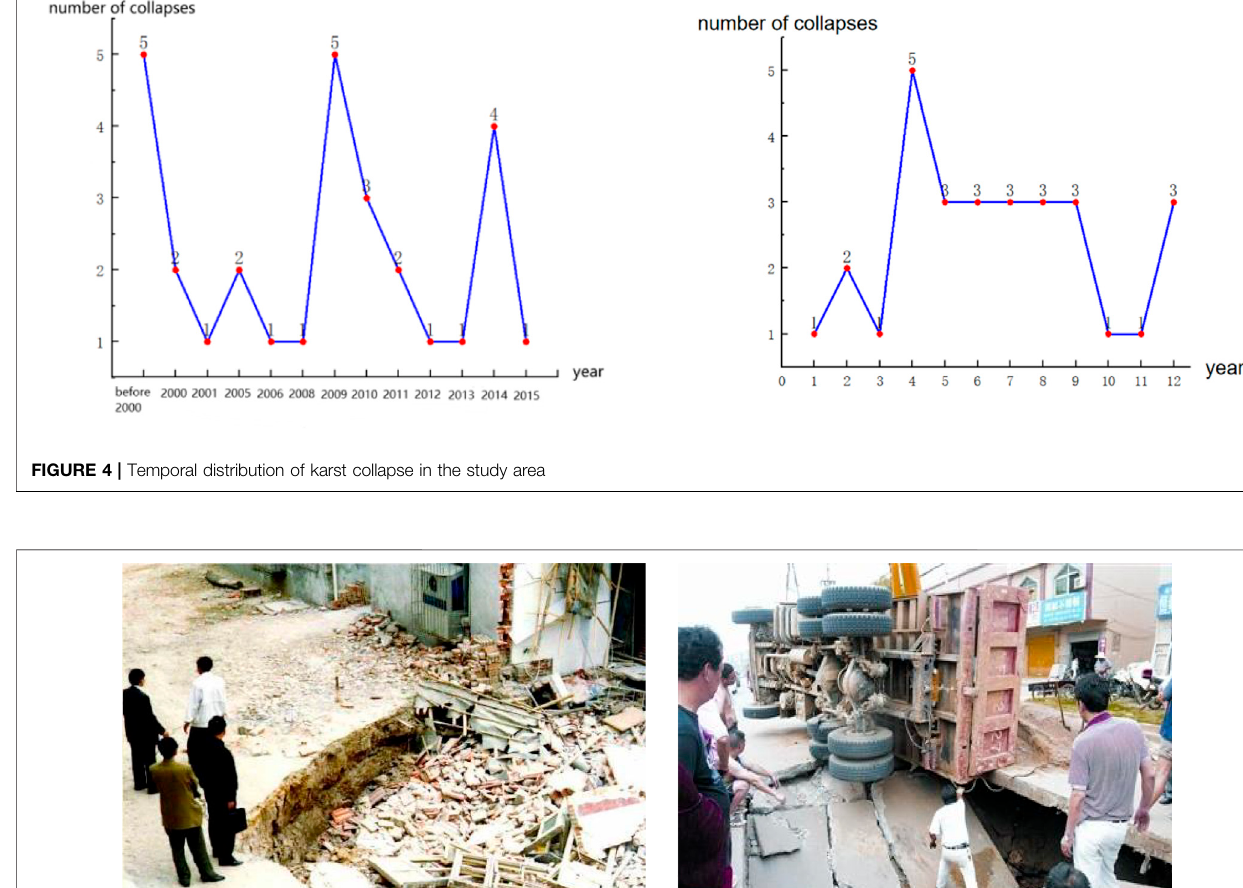
Frontiers in Earth Science |